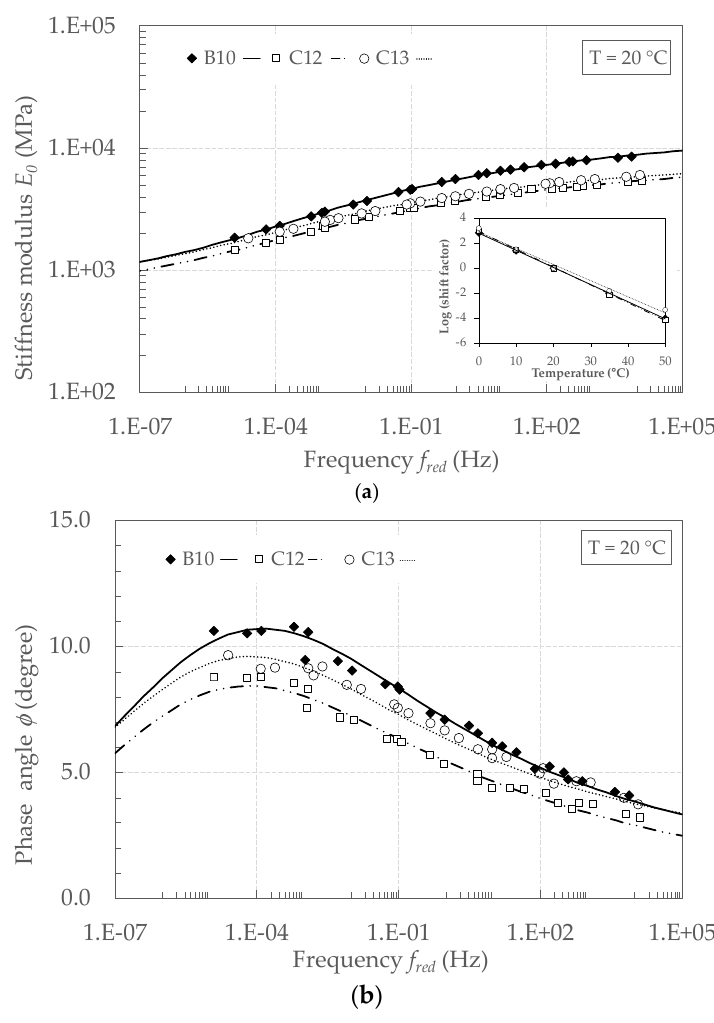
φ . 0 ; ( b ) phase angle